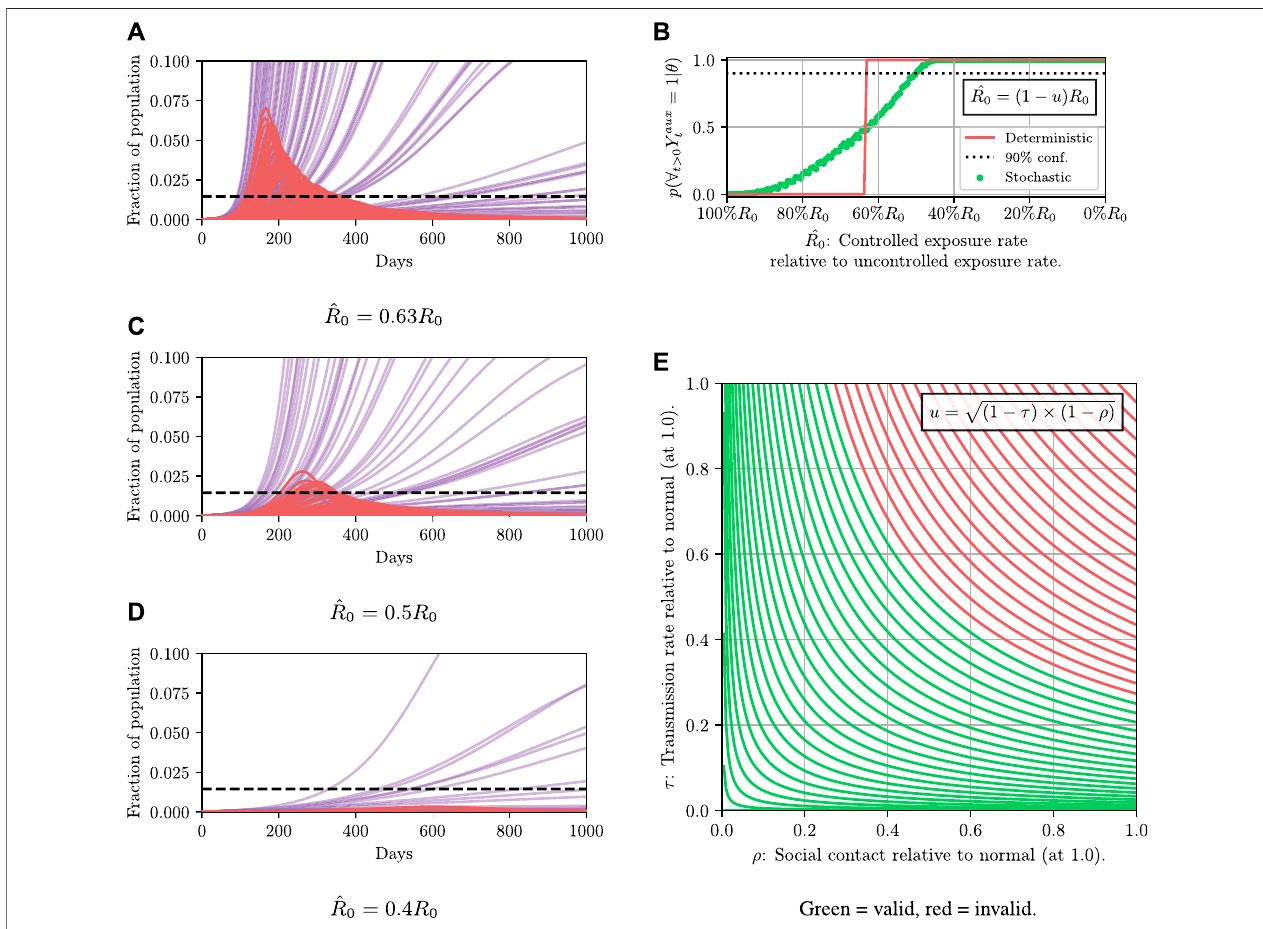
FIGURE 5 | Comparison of stochastic and deterministic SEI 3 R models for policy selection. We reuse the colour scheme de fi ned in Figure 2A for trajectories. (A) shows a stochastic simulation using ^ R 0 (cid:1) 0 . 63 R 0 , identi fi ed as an acceptable parameter value under the deterministic model. However, once used in a stochastic system,theparameterperformspoorly,yieldingmanysimulationsthatviolatetheconstraint.Thishighlightswhyanalysesindeterministic systemscanyieldpoorresults. (B) repeats the analysis in Figure 4A adding planning in the stochastic simulation, where the y -coordinate can now be interpreted as the con fi dence level. (C) showsasimulation usingthelowestvalidvalueof u ,representingthe “ weakest ” validpolicy.Thisvalue,approximately ^ R 0 (cid:1) 0 . 5 R 0 ,rendersmostofthetrajectoriesunder the threshold, with only a smallfraction above, implying that it will satisfy the criteria with high probability. (D) shows that using ^ R 0 (cid:1) 0 . 4 R 0 effectively reduces the level of infection to near zero. (E) illustrates an example of how policy-level variables create model-level parameter values. Shown are the level-sets of the free parameter u ∈ [ 0 , 1 ] ,whichactstoreducethebaselinereproductionrate R 0 as ^ R 0 (cid:1) ( 1 − u ) R 0 .Wesuggestthatthereductioninthe(unknown)reproductionrateisgivenbytheroot oftheproductoftwofactorscontrollablethroughpolicy.Greenlevelsetsindicatethatthevalueof u waseffectiveandachieveda90 % con fi dencethatthetrajectorydoes not violate the constraint, whereas red curves do not satisfy